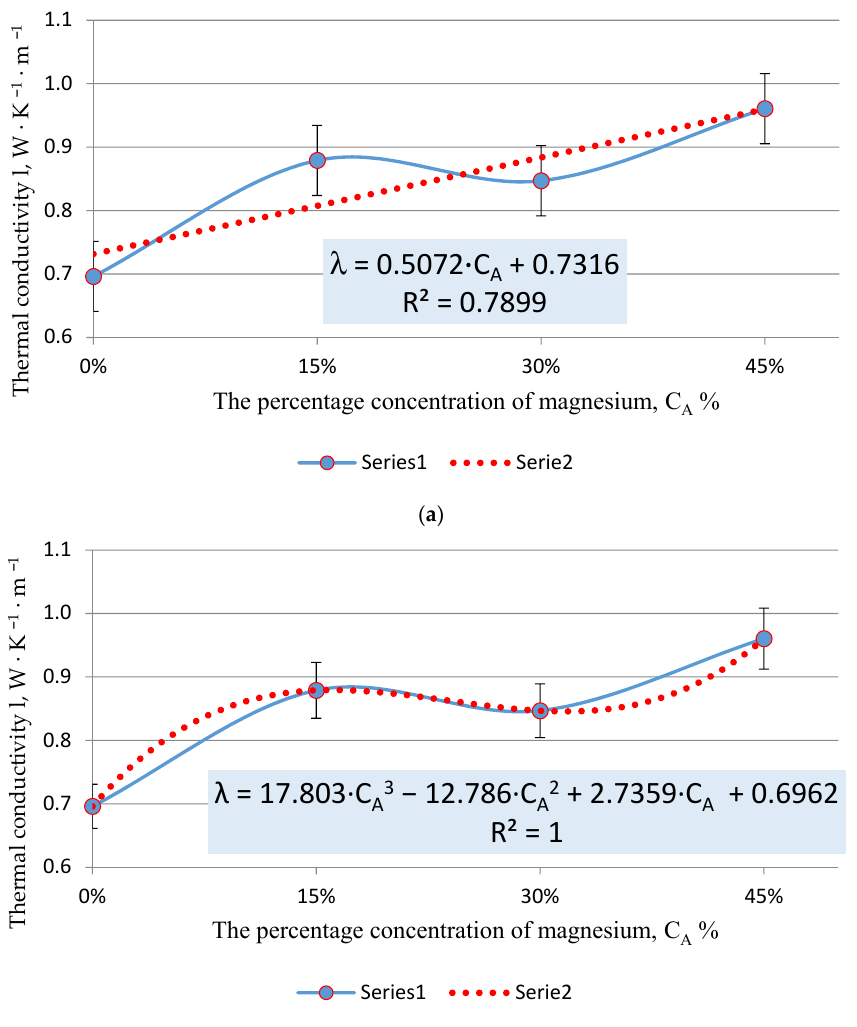
Figure 5. The influence of magnesium shavings concentration on the average thermal conductivity values: ( a ) trend line as a linear function, ( b ) trend line as a polynomial function; Series 1—graph based on the measurement results, Serie 2—trend line.